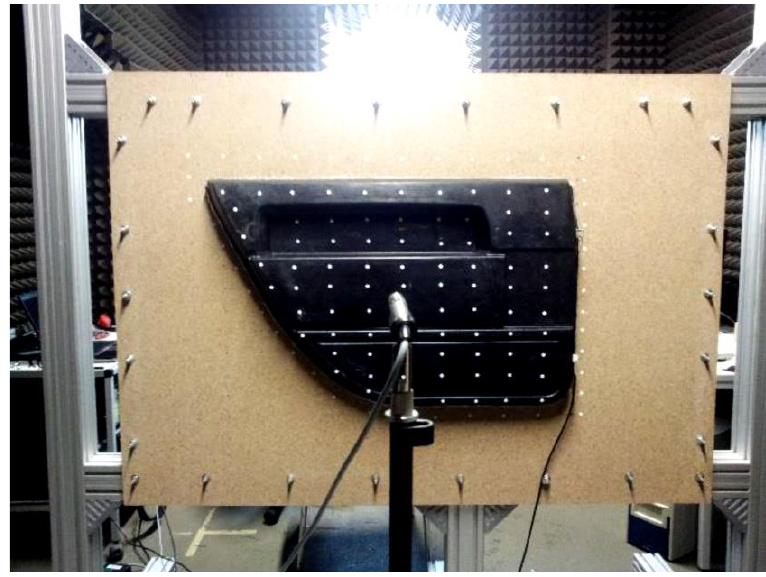
Figure 11. Microphone placed in 1 m distance to the panel.